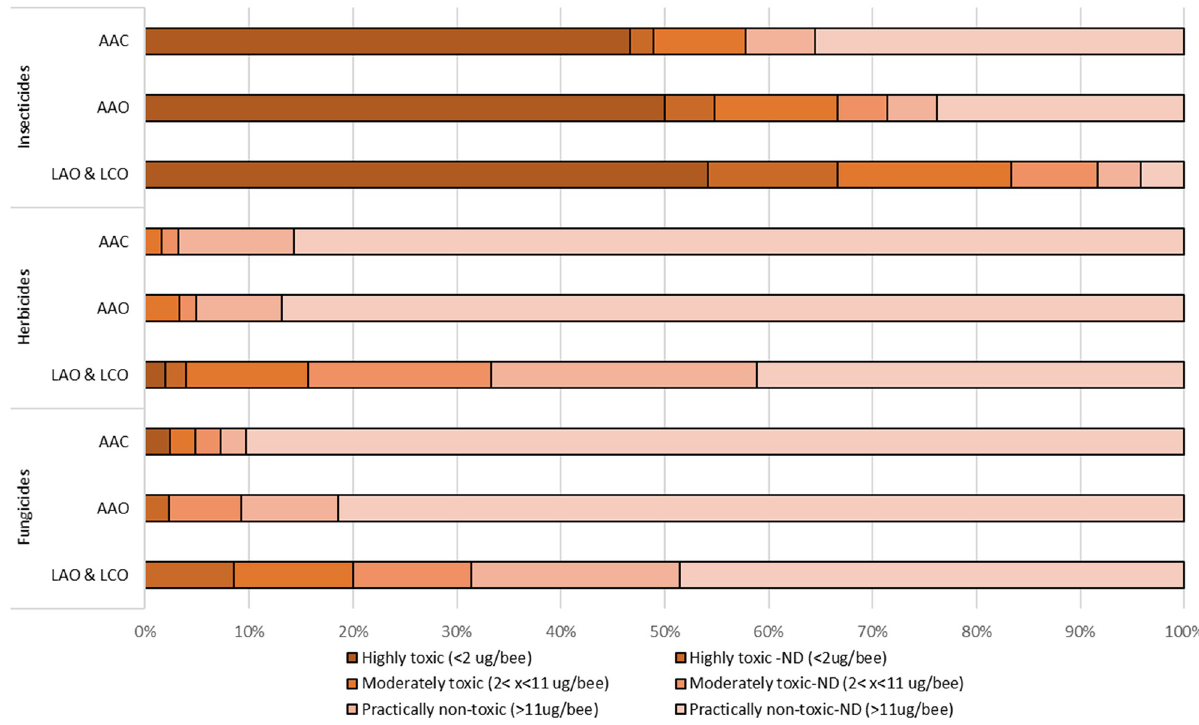
Fig 1. Proportional relationships of toxicity categories across adult and larval life stages and exposure based on contact and oral LD 50 values for insecticides, herbicides, and fungicides. AAC- Adult Acute Contact (n = 149), AAO- Adult Acute Oral (n = 146), LAO Larval Acute Oral & LCO— Larval Chronic Oral LD 50 s (n =